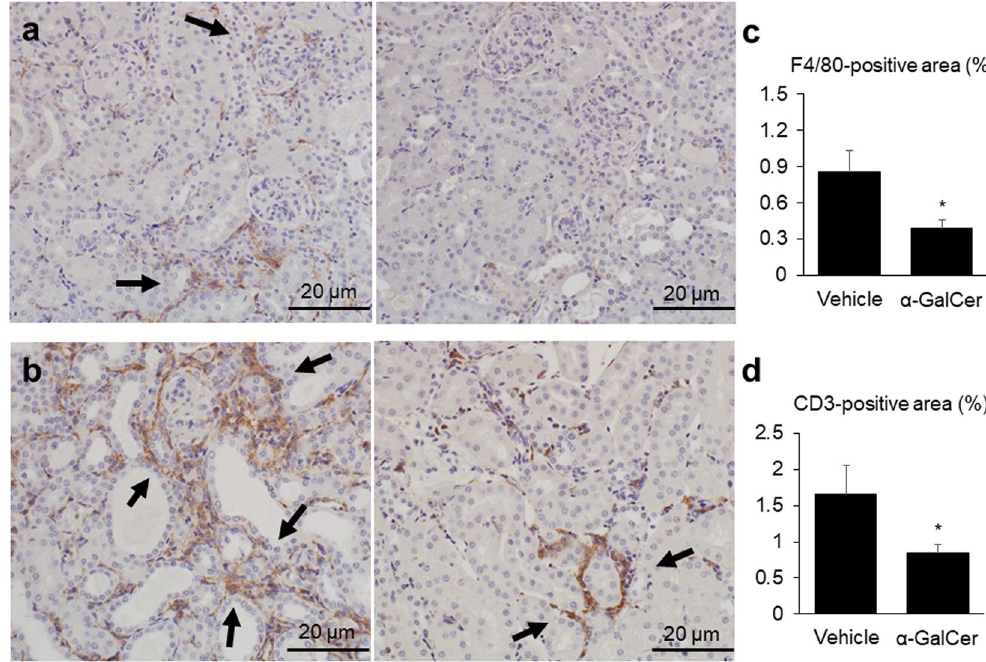
Figure 3. Alpha-galactosylceramide ( α -GalCer) treatment decreases the infiltration of inflammatory cells into the kidney. Representative images of ( a ) F4/80-stained and ( b ) CD3-stained kidney slices in the vehicle (left) and α -GalCer (right) groups. In each panel, arrows indicate F4/80 or CD3-positive areas. The percentages of the ( c ) F4/80-positive area and ( d ) CD3-positive area in each group (vehicle group; n = 5, α -GalCer group; n = 7). * p < 0.05 compared with the vehicle